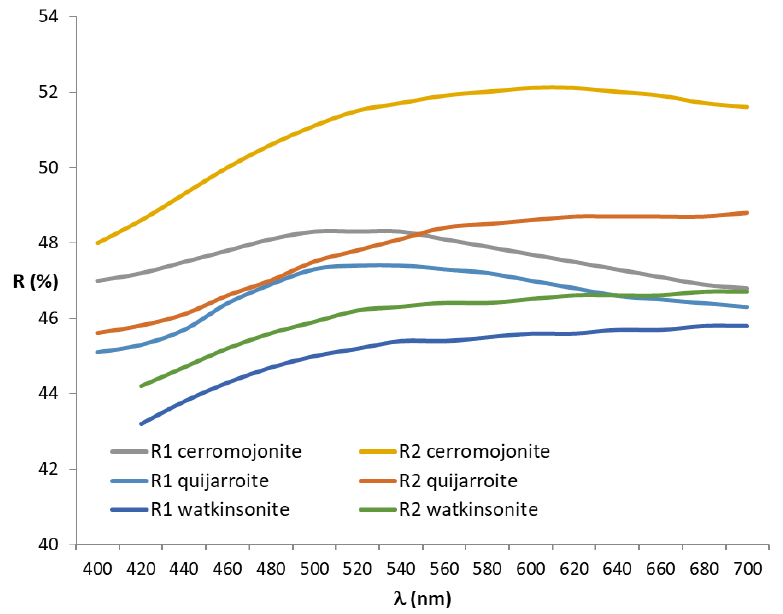
Figure 8. Reflectance spectra of type-II cerromojonite and its most frequently associated Cu–Bi selenides: quijarroite [6] and watkinsonite